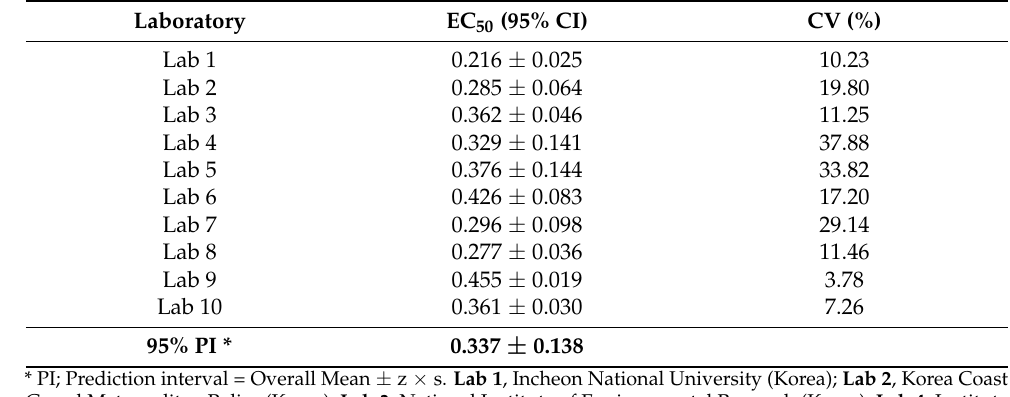
Table 4. Interlaboratory precision of EC 50 (mg L − 1 ) from the Lemna toxicity